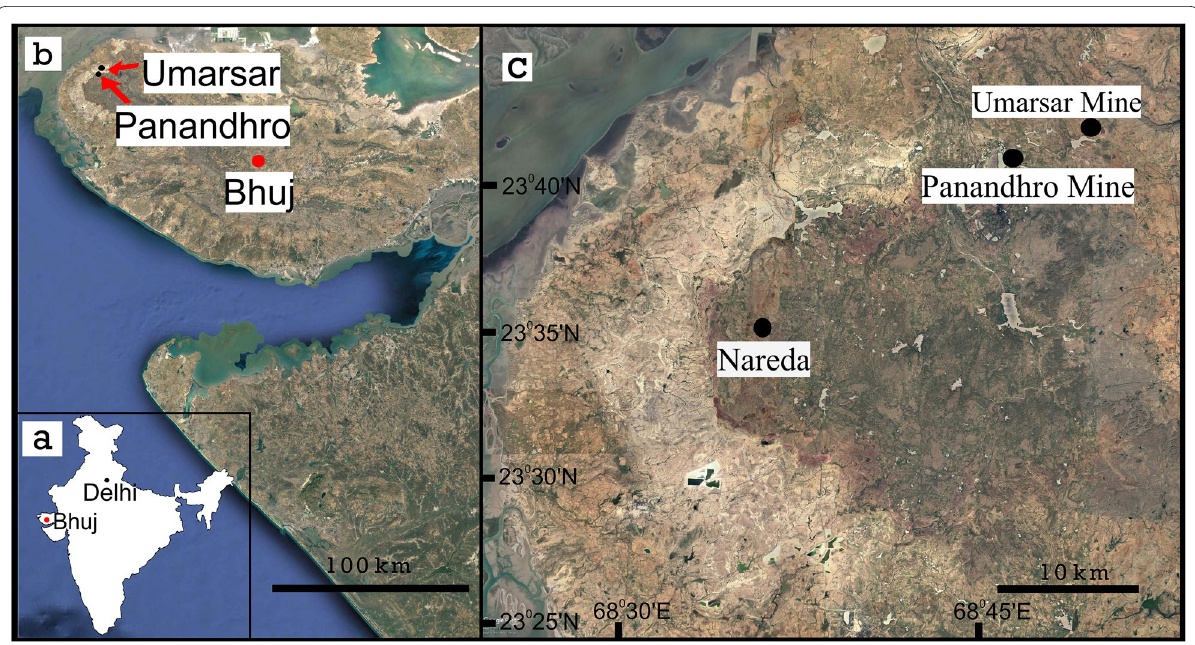
Fig. 1 Map of the study area in Kutch, India. a Map of India. b Position of the study area. c Location of the Umarsar and Panandhro mines. Nareda village, the type locality of the Naredi Formation is also